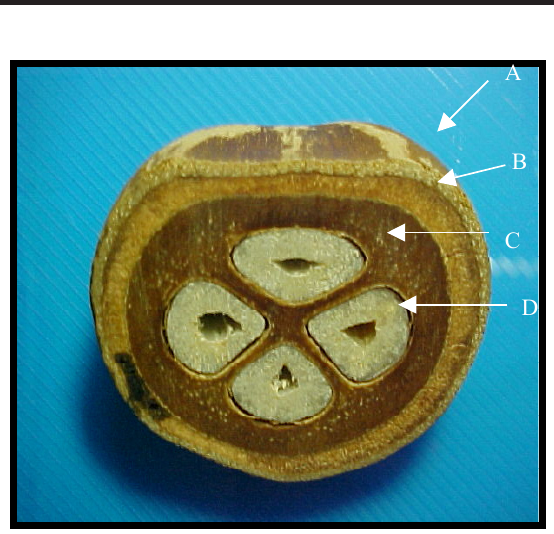
FIGURA 1 – Coco do babaçu. Legenda: A) Epicarpo; B) Meso-Coco do babaçu. Legenda: A) Epicarpo; B) Meso - carpo; C) Endocarpo.; D)